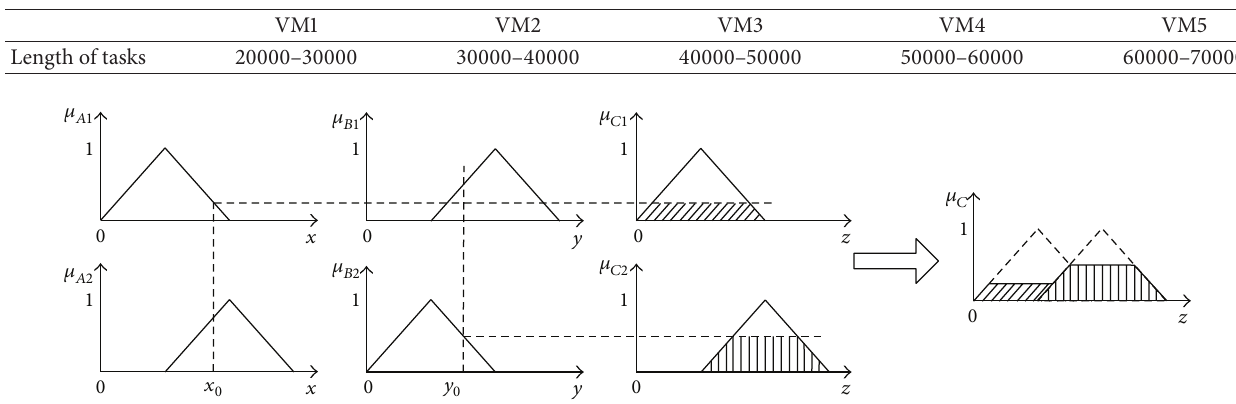
Table 3: The task allocation schemes.